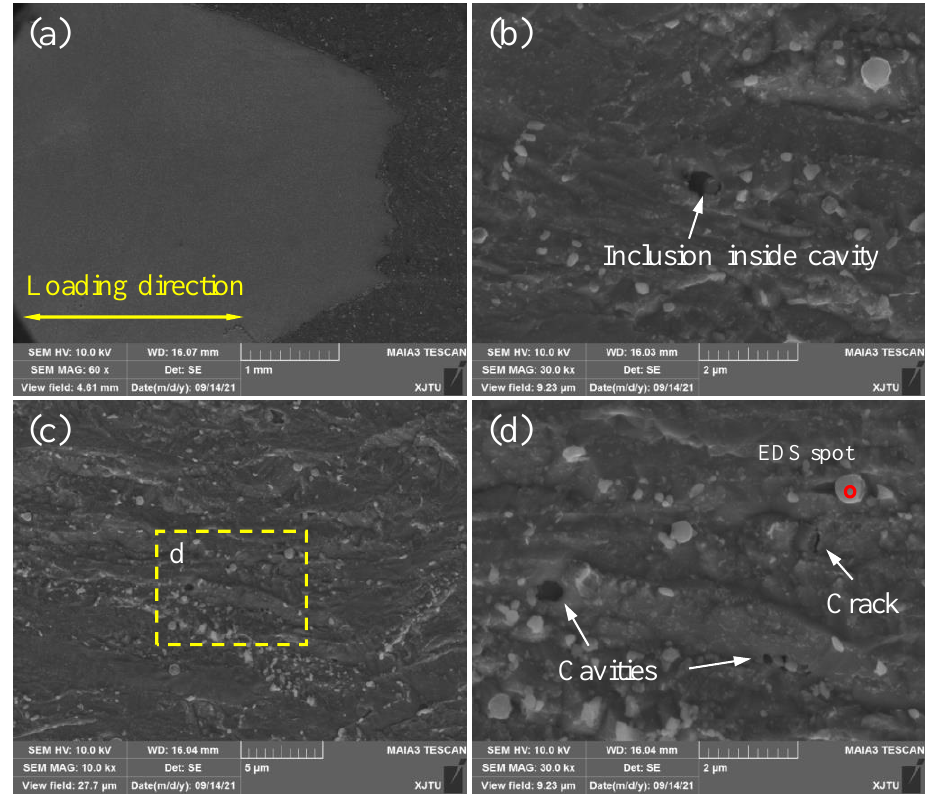
Figure 10. SEM images of the main damage zone of creep-ruptured WM specimen at 550 °C. ( a ) The overall micrograph of the longitudinal cross-section; ( b , c ) are the distribution of creep cavities; ( d ) is the magnified graph of corresponding creep cavities in ( c ).